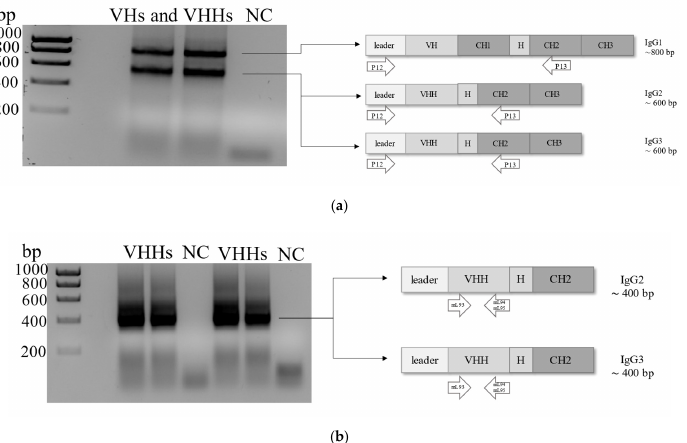
Figure 2. Agarose gel (1.5%) electrophoresis after the amplification of camelid VHs and VHHs. ( a ) The upper band at about 800 bp corresponds to the leader-VH-hinge-CH1-CH2 sequence of camelid conventional antibodies (IgG1) and the lower band at about 600 bp to the leader-VHH-hinge-CH2 sequence of unique heavy-chain-only antibodies. Amplicons of 600 bp were used as templates for the nested PCR. ( b ) Nested PCR amplified the VHH sequences of about 400 bp only (without leader and hinge region) using the forward primer mL93 and two reverse primers mL94 and mL95. For each PCR, DEPC-treated water was included as a negative control (NC, no template control). Hyperladder I™ 1 kb was used as DNA molecular weight marker (Bioline, London, Great